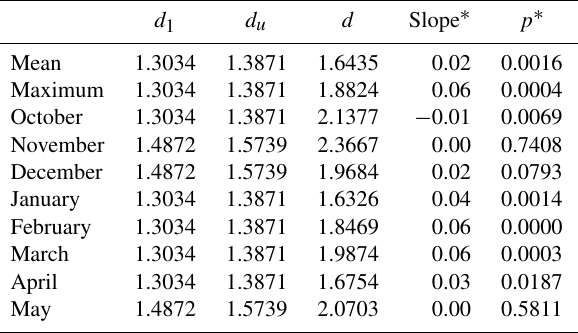
Figure A1. Normal distribution of annual mean snow depth for all stations by Kolmogorov–Smirnov test.